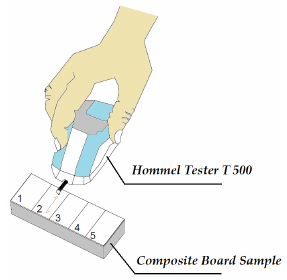
Figure 2. Roughness Test of Composite Panels Using Stylus method.